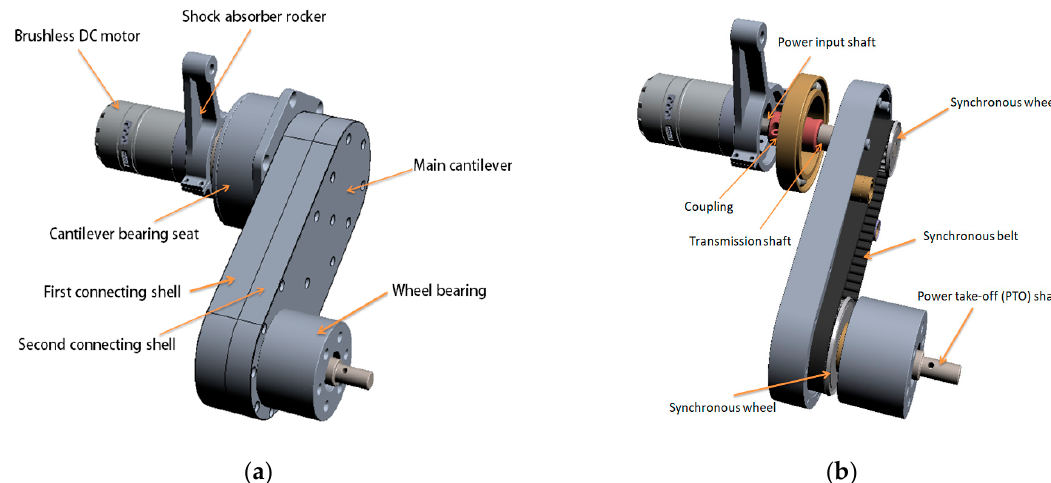
Figure 2. 3D diagram of suspension device: ( a ) external structure; ( b ) internal structure.